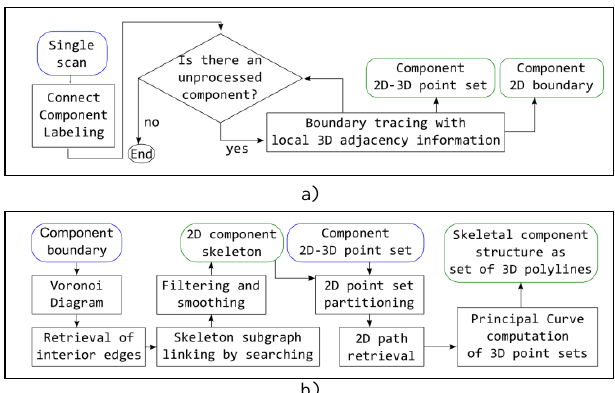
Figure 2. Two-stage processing strategy. Rounded boxes denote inputs (blue) and outputs (green). a) Segmentation of single scans into connected components. b) Retrieval of skeletal structures from components.